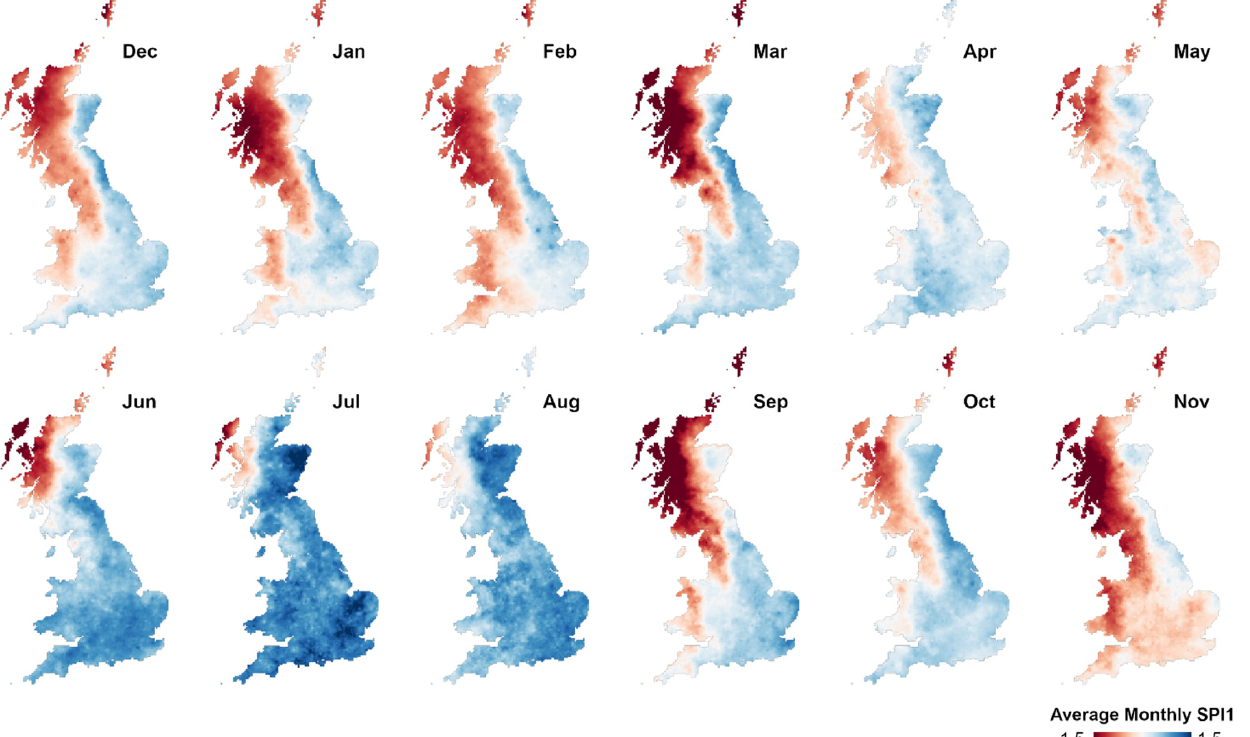
Figure 3. Average monthly SPI-1 values under NAO − conditions (January 1900–December 2015).